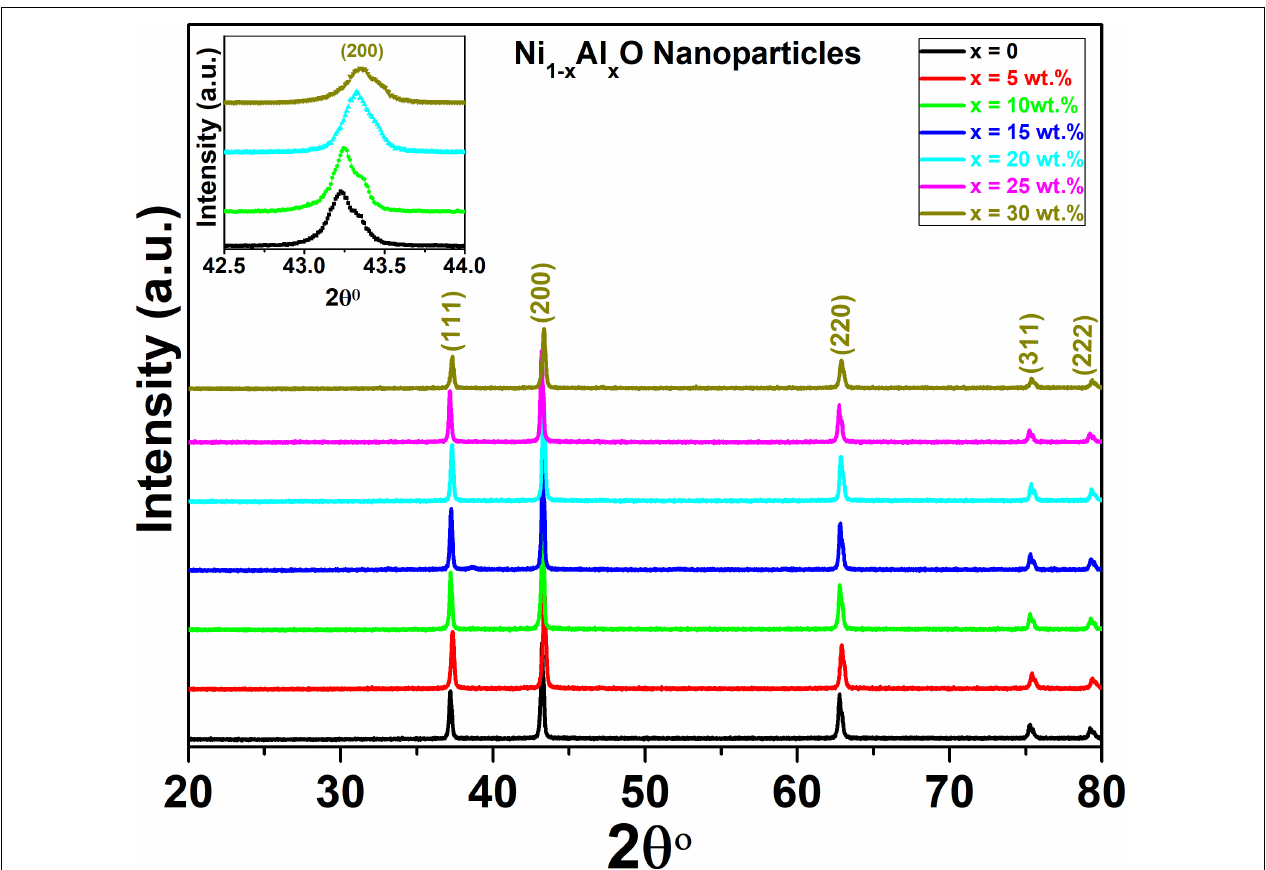
FIGURE 1 | XRD spectra of Ni 1 − x Al x O; x = 0, 5, 10, 15, 20, 25, and 30 wt.% nanoparticles. In the inset there is shown the shifting of characteristic peak corresponding to (200) plane of FCC crystal structure of Ni 1 − x Al x O